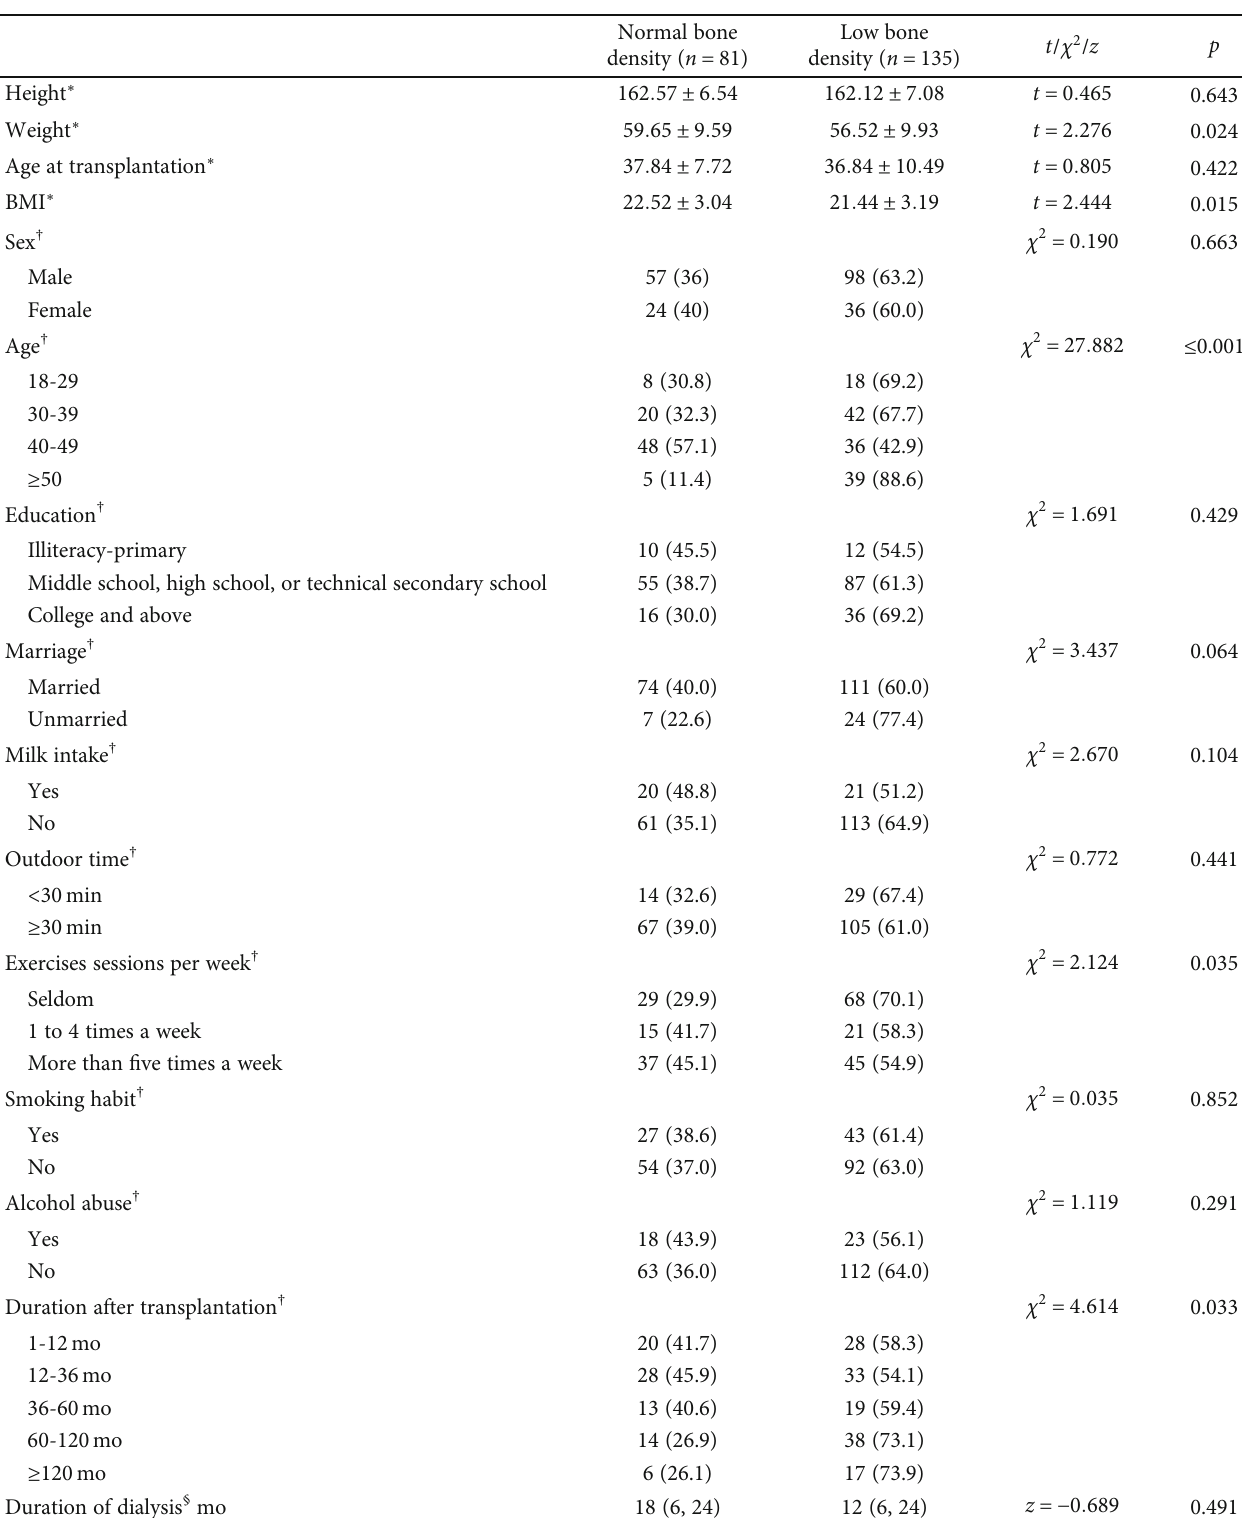
Table 1: Baseline demographic, anthropometric, and lifestyle variables of the